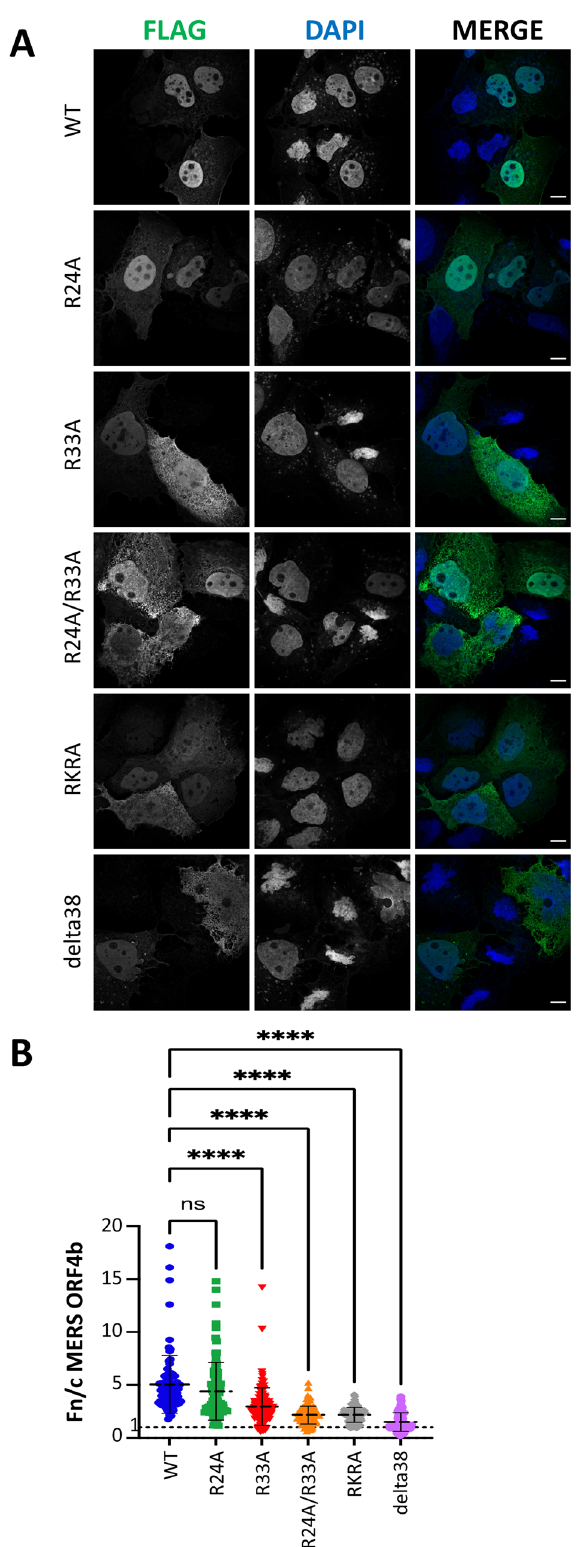
Table 11 for data and re fi nement statistics, and Supplementary Table 14 for hydrogen bond interactions). The NLS site also shifted, with HKU5 binding at the major and minor sites with the same sequence, RKRRRHP 37 . The equivalent sequence in